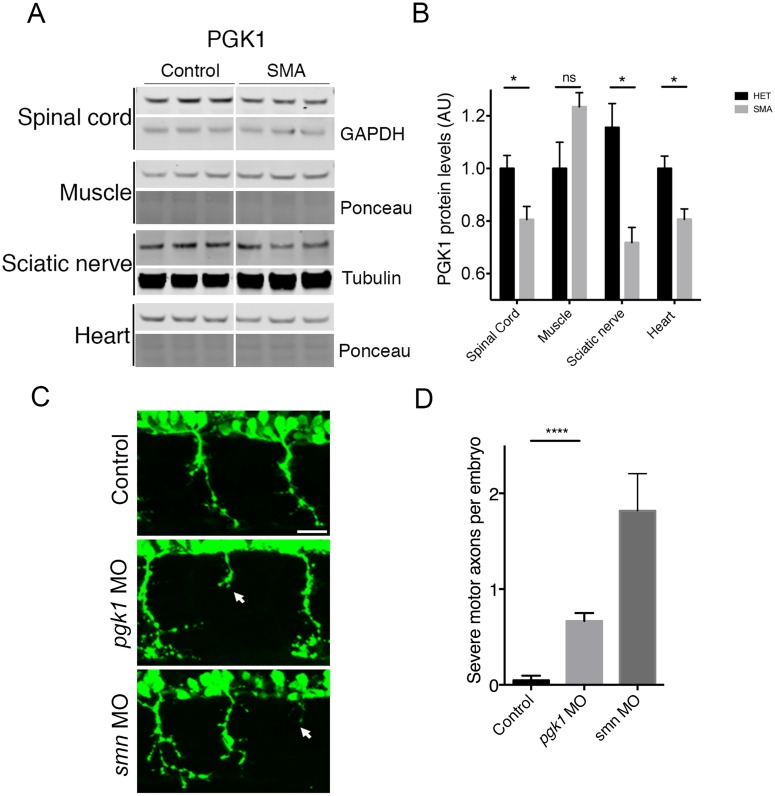
Pgk1 expression is pathologically relevant in mouse and zebrafish models of SMA.(A) Expression of PGK1 protein in the spinal cord, skeletal muscle, sciatic nerve and heart of late-symptomatic P8 SMA mice. Protein levels were quantified and normalized to an appropriate loading control. (B) Bar chart (mean & s.e.m.) showing a significant reduction in PGK1 protein levels in SMA mouse spinal cord and sciatic nerve. N = 6 SPC per genotype. N = 3 muscle per genotype. N = 7 sciatic nerves per genotype. N = 3 hearts per genotype (C) Knockdown of Pgk1 in zebrafish induced an axonal outgrowth phenotype (middle panel arrow) similar to smn knockdown (arrow bottom panel) and also produced swellings in the tips of outgrowing axons indicative of axonal transport deficiencies. Scale bars = 50 μM (D) Quantification of axonal outgrowths showed a significant increase in truncated motor axons in pgk1 and smn morphants compared to controls. (E) Efficiency of pgk1 knockdown in embryos was shown by western blot embryos normalized to an appropriate loading control (N = 3 per group, batches of 30 pooled zebrafish embryos per lane). N = 20 embryos per group. Unpaired two-tailed students t-test * p<0.05, ** p<0.01 *** p<0.001 **** p<0.0001.